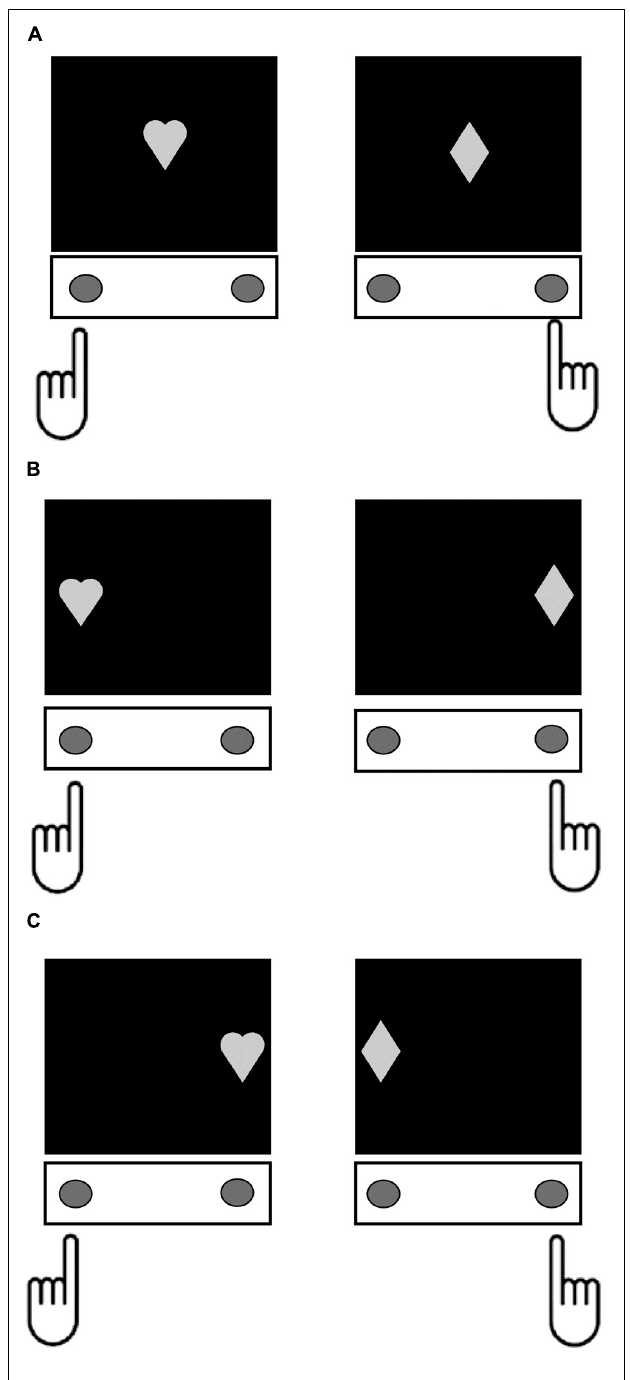
FIGURE 1 | Depiction the different trial conditions in the Simon task. For each trial type, participants responded by pressing the button under their left index finger when the stimulus was a Heart, and the button under their right index finger when the stimulus was a Diamond. (A) Control condition – the target stimuli appeared at central fixation. (B) Congruent condition – the target stimuli appeared at a location on the screen that was compatible with the spatial orientation of the correct response (left side for Heart and right side for Diamond). (C) Incongruent condition – the target stimuli appeared at a location on the screen that was incompatible with the spatial orientation of the correct response (right side for Heart and left side for